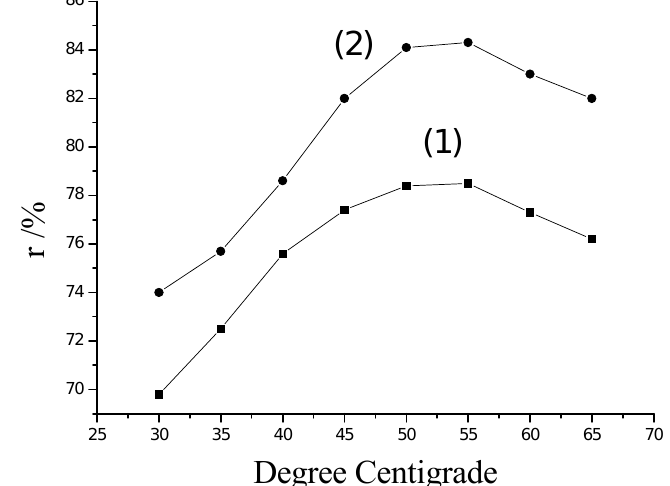
Figure 4. Effect of reaction temperature on desulfurization in model